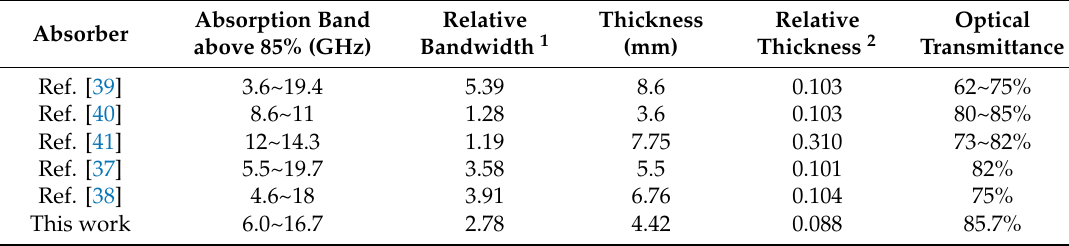
Table 2. Comparison with other transparent broadband absorbers.